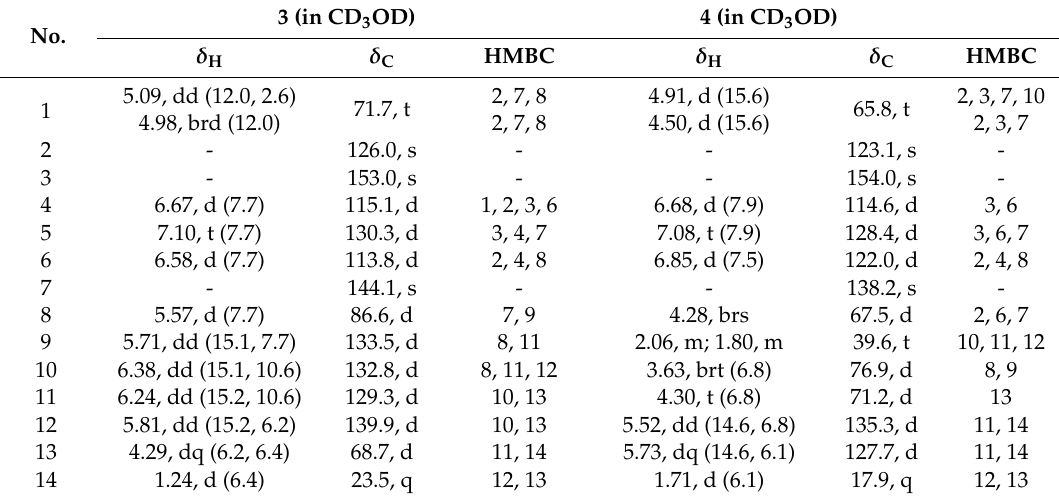
Table 2. 1 H and 13 C NMR Data of Compounds 3 and 4 ( δ in ppm, J in Hz). 3 (in CD 3 OD) 4 (in CD 3 OD) No. δ